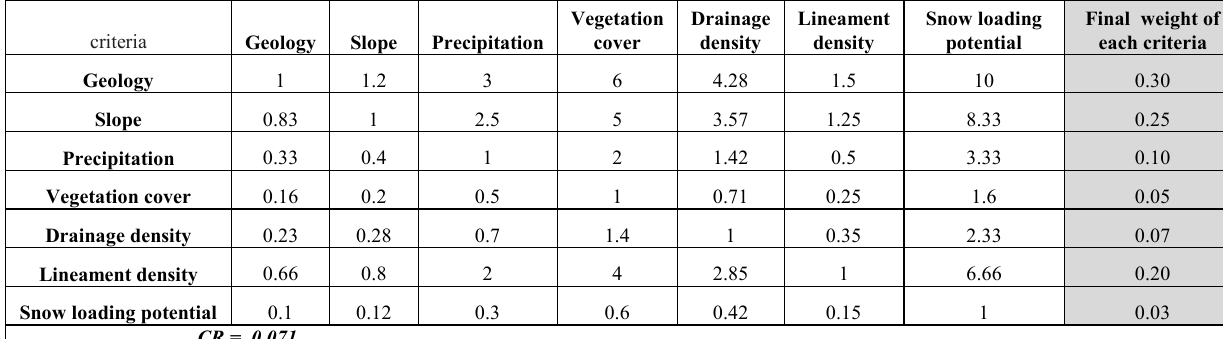
Table 1: Pairwise comparisons matrix for AHP analysis and the consistency index criteria